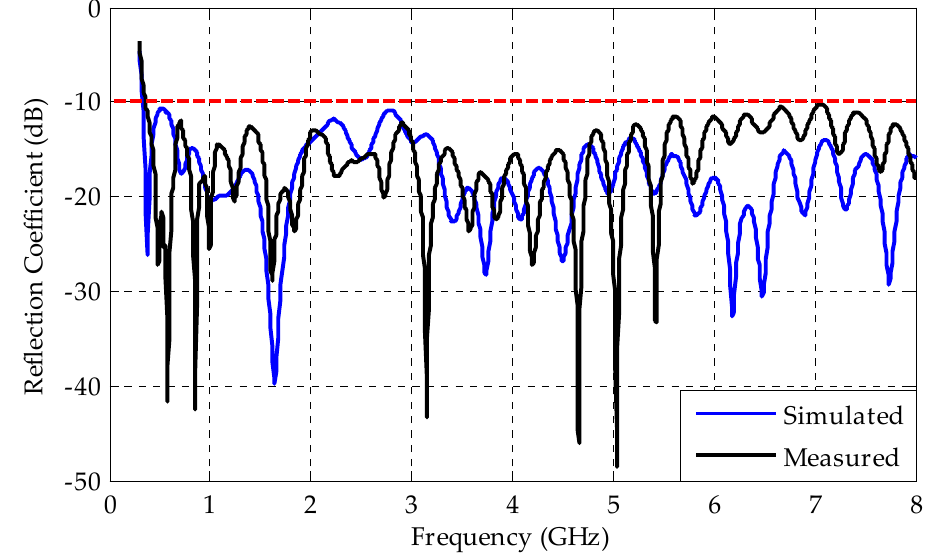
Figure 9. Measured and simulated reflection coefficients for the bio ‐ inspired PMA.